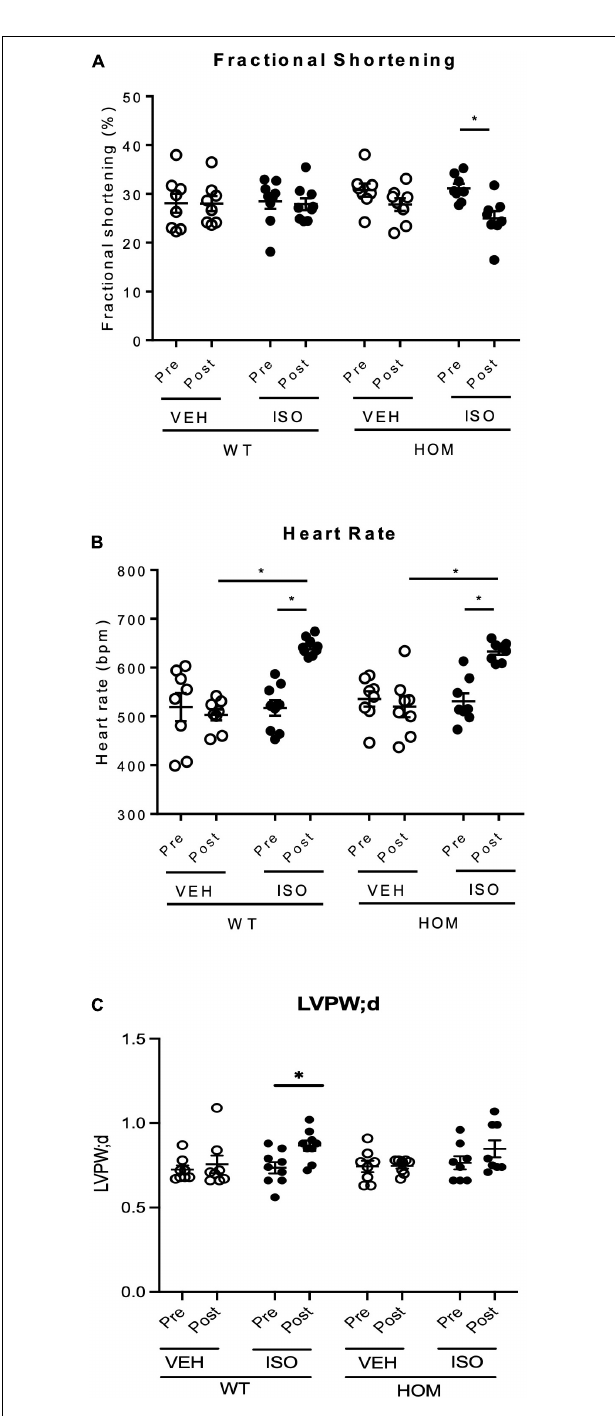
FIGURE 5 | Cardiac response to sustained β -adrenergic stimulation in male Tcap S157 / 161A KI mice. Male mice (8–10 weeks) were implanted with osmotic mini-pumps containing either 0.9% NaCl (VEH) or isoprenaline (ISO) at a delivery rate of 30 mg/kg/day for 14 days. Echocardiographic data shows (A) fractional shortening, (B) heart rate, and (C) LV posterior wall thickness in diastole (LVPW;d) in mice prior to osmotic pump implantation (Pre) and 14 days later (Post) ( n = 8–9). Data expressed as mean ± SEM, ∗ p ≤ 0.05; two-way ANOVA with Tukey’s post hoc test (genotype and treatment group) or Sidak’s post hoc test (treatment